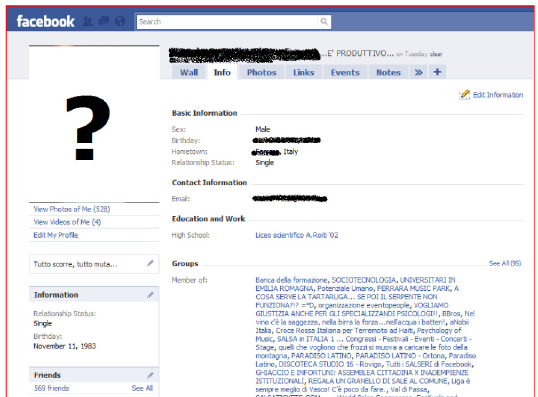
Figure 3. Profile of a hypothetical student on Facebook (image taken from the original on